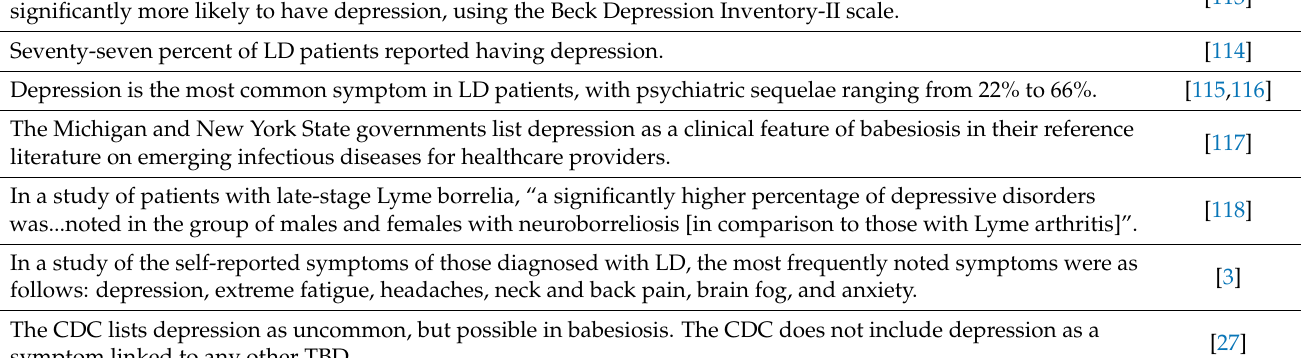
Table 12. Depression is found in many patients with LD and is noted by a state-level public health report as a clinical feature of babesiosis.